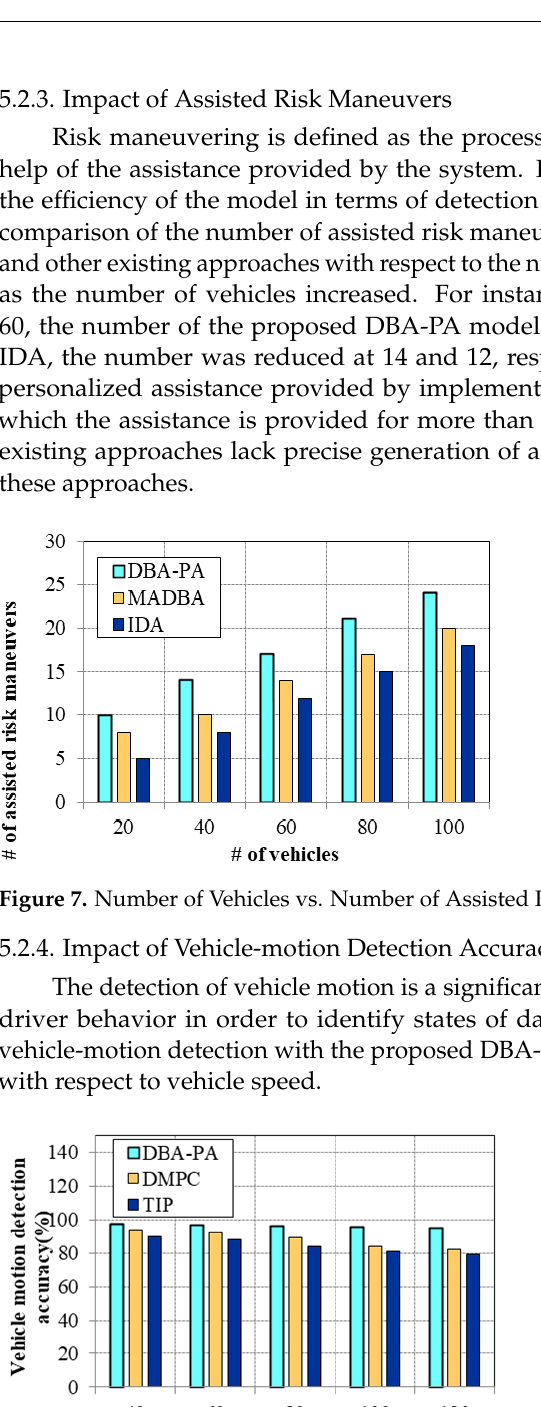
Figure 6. Number of Vehicles vs. Number of Alerts.